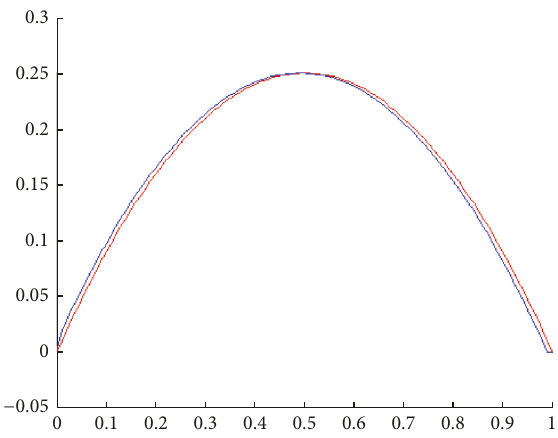
Figure 1: Initial temperature. This figure shows that we can rebuild the initial